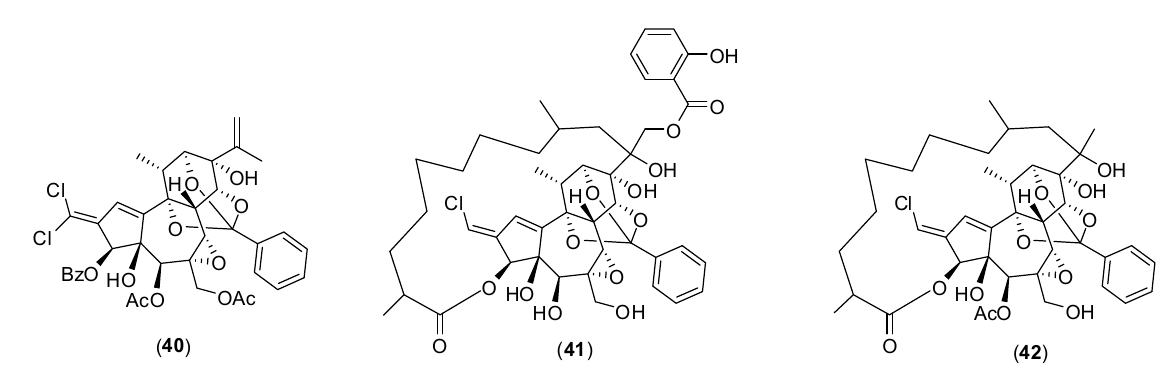
Figure 17. Structures of terpenes 40 , 41 and 42 .